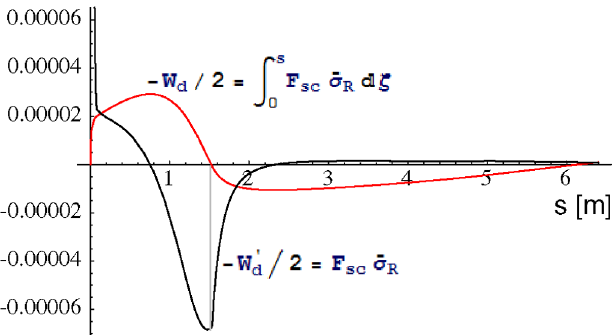
(cid:6) s (cid:7) in red and W 0 (cid:6) s (cid:7) in black. Emittance d d (cid:3) 0 at the booster entrance around d